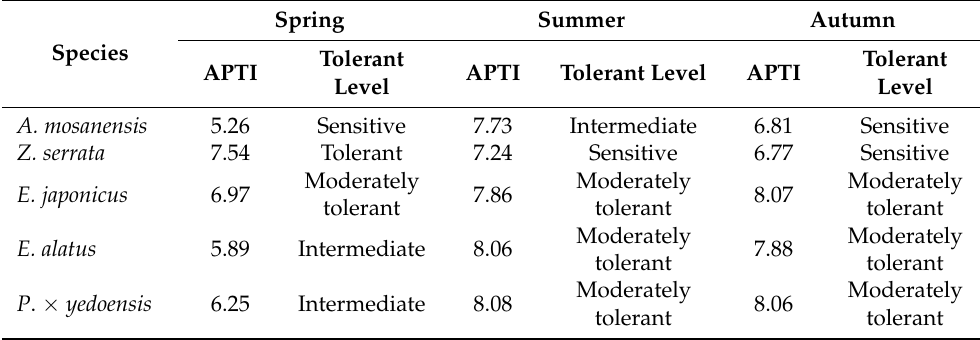
Tolerant Level Moderately Moderately Moderately